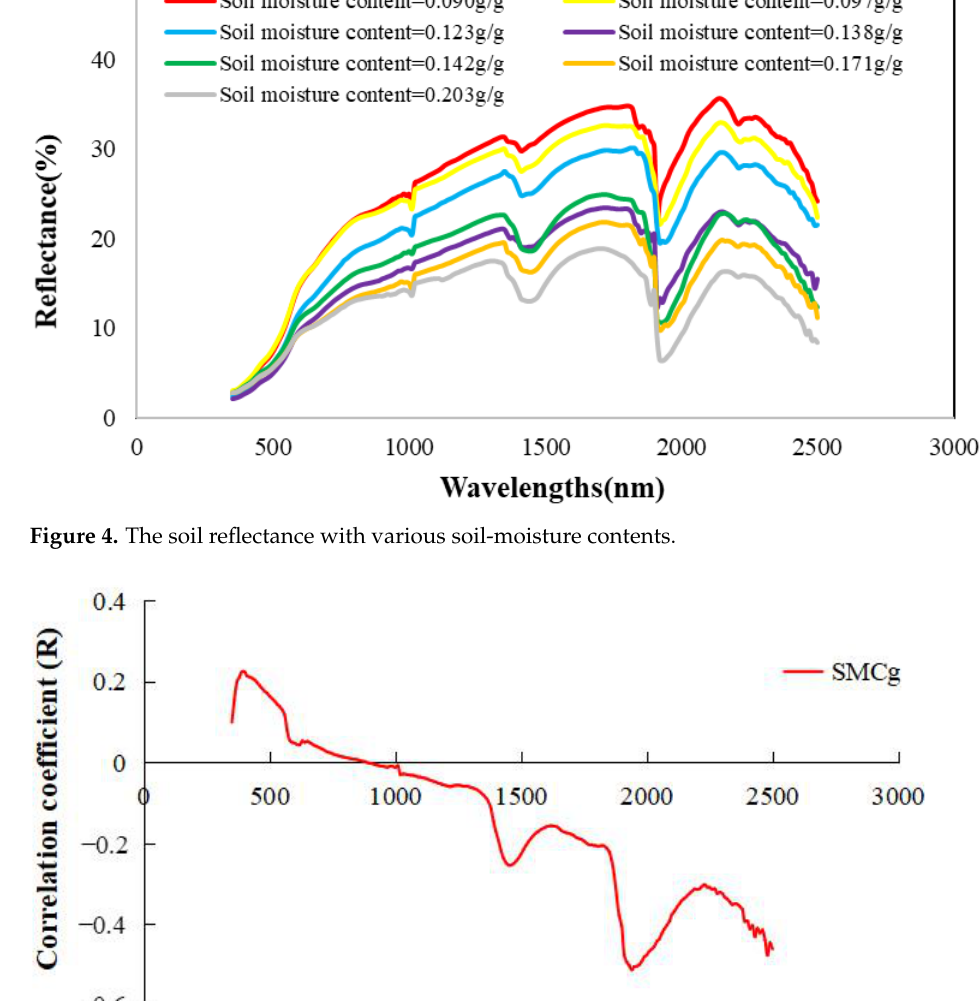
Figure 4. The soil reflectance with various soil-moisture contents.